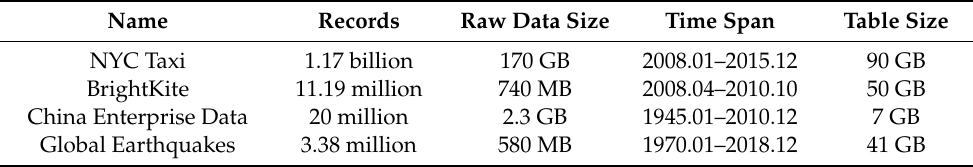
Table 2. Detailed information of our experimental